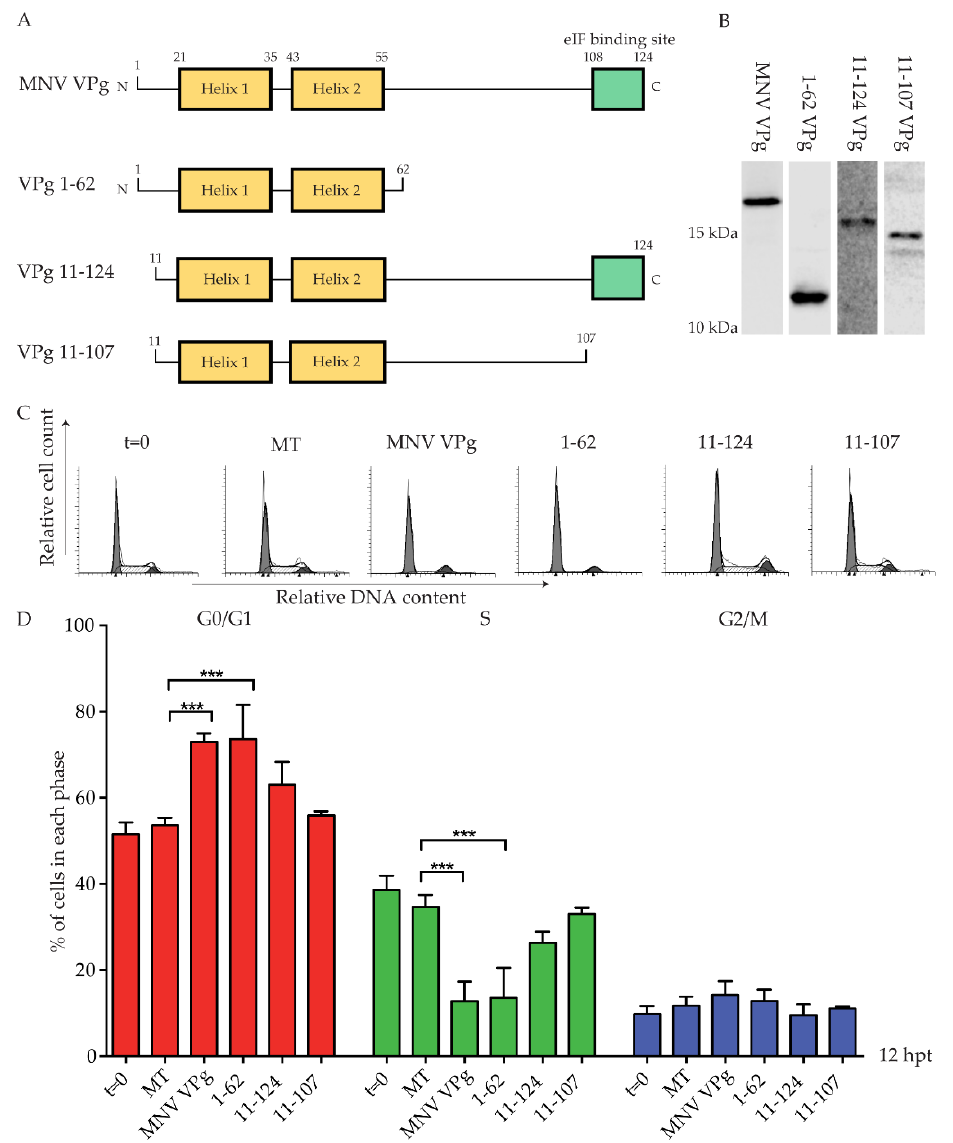
Figure 3. Expression of VPg 1–62 induces a G0/G1 phase cell cycle arrest. RAW-Blue cells were transfected with 4–5 µ g of in vitro transcript RNA corresponding to MNV VPg, VPg 1–62, VPg 11–124, or VPg 11–107. Mock transfected (MT) cells were seeded at the time of transfection as a negative control. At 12 hpt, cells were harvested for western blot and FACS analysis of the cell cycle. ( A ) Schematic of full-length MNV VPg and synthetic constructs. Numbers indicate the amino acid position within key structural elements. ( B ) Representative western blot of full length MNV VPg and VPg truncations. Histograms ( C ) from FACS analysis were analysed on MODfit LT 3.0, and the percentage of cells in each phase of the cell cycle graphed ( D ). The results present the mean and SD from three independent experiments. Statistical significance was determined for comparisons between transfected cells and mock transfected cells using a one-way ANOVA with Dunnett’s post-test. *** p ≤